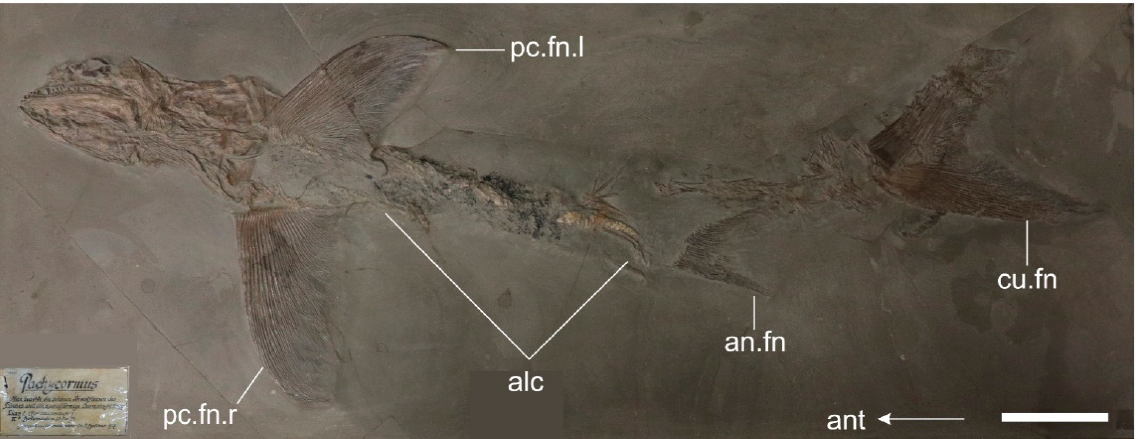
Figure 2. Germanostomus pectopteri , holotype. SMNS 15815 prepared from the underside revealing the skeleton in left lateroventral view. Note the contrast in articulation quality between the anteroventral and posterodorsal regions of the skeleton, implying a head-first burial within the soft substrate. alc, alimentary canal; an.fn, anal fin; ant, direction towards anterior of fish; cu.fn, caudal fin; pc.fn, pectoral fin (l, left; r, right). Scale bar = 100 mm.